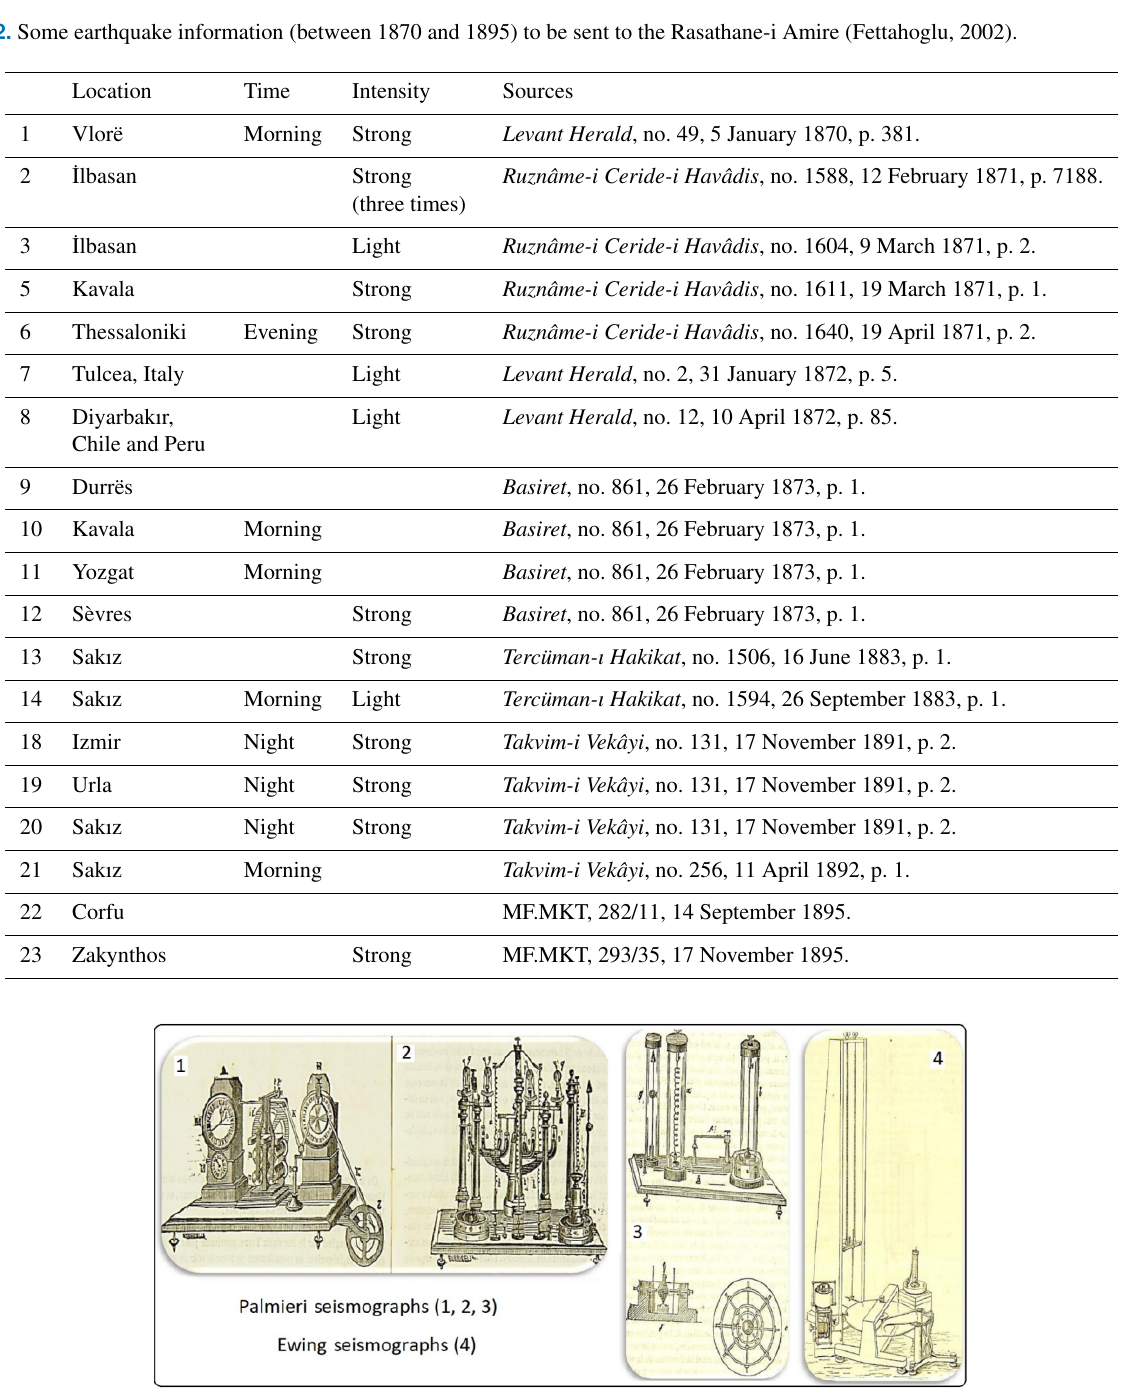
Figure 7. Seismograph proposals for the Ottoman